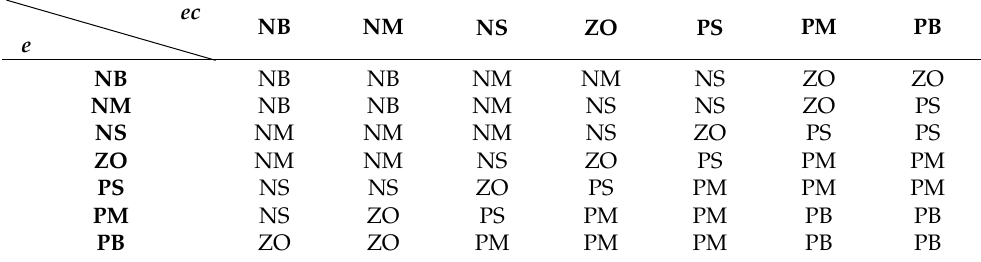
Table 1. The fuzzy control rules table of ∆ k p .